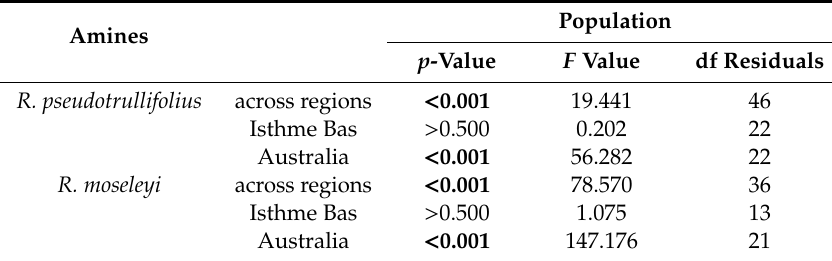
Table 2. Differences among populations in the composition of amines or quercetins *.